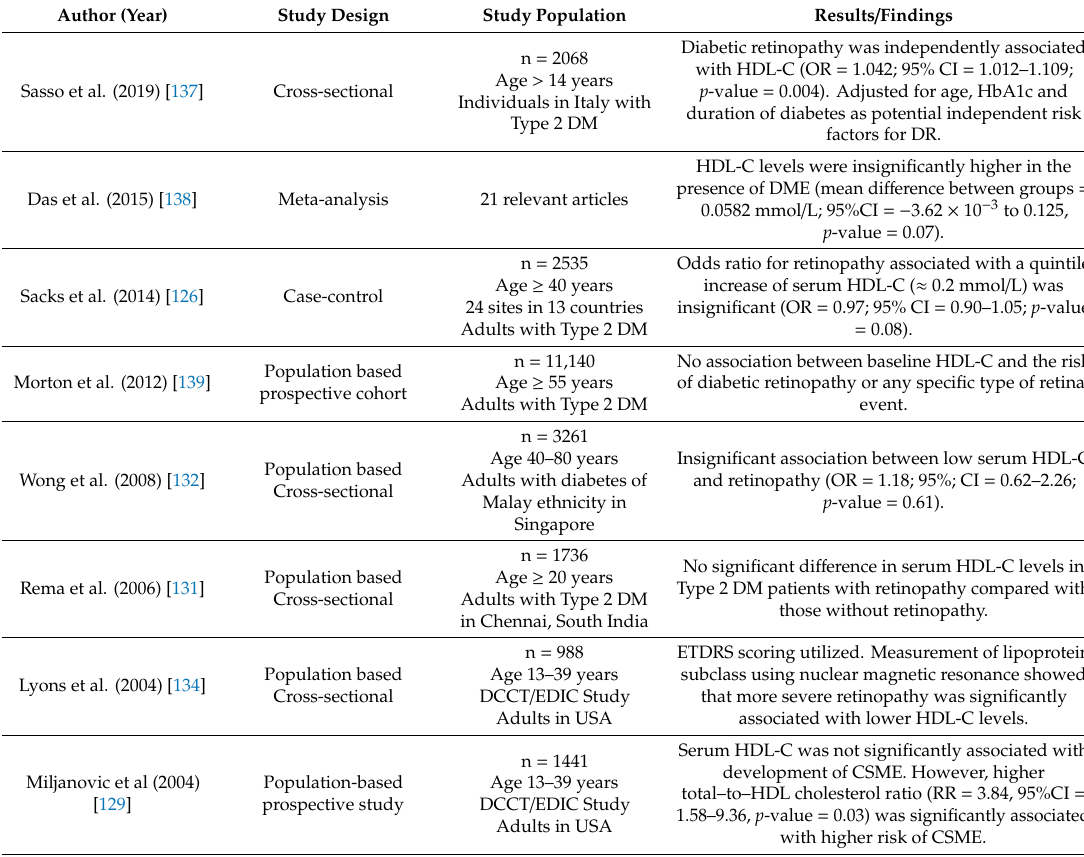
Table 5. HDL-C and Diabetic Retinopathy—Epidemiological Links from Observational